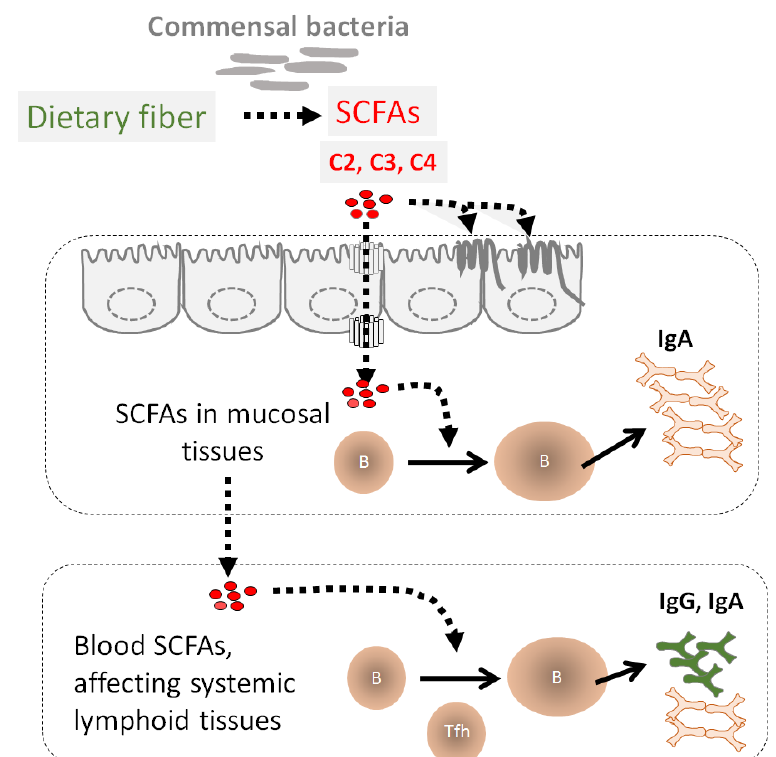
FIGURE 1: DF boosts antibody production through SCFAs. Soluble DF and digestion- resistant starches that reach the colon are fermented by commensal bacteria. This process generates SCFAs, which are ab- sorbed by colonocytes. Some of the ab- sorbed SCFAs are used by colonocytes